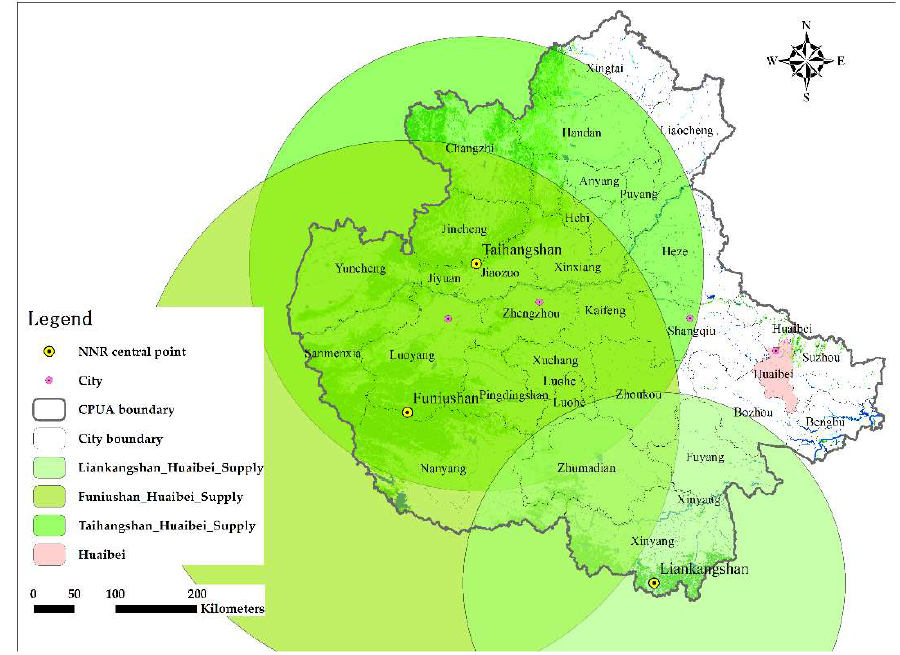
Figure 10. Integrated ES supplies of ecospace ES to Huaibei.